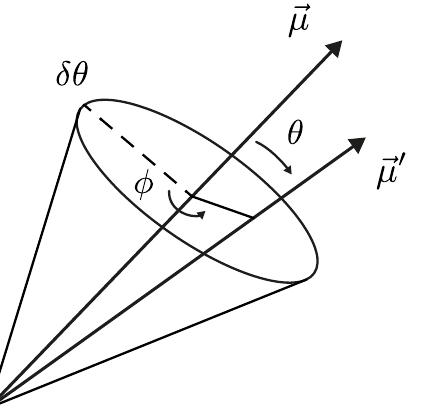
Figure 3. Cone used to choose the random motion of the magnetic